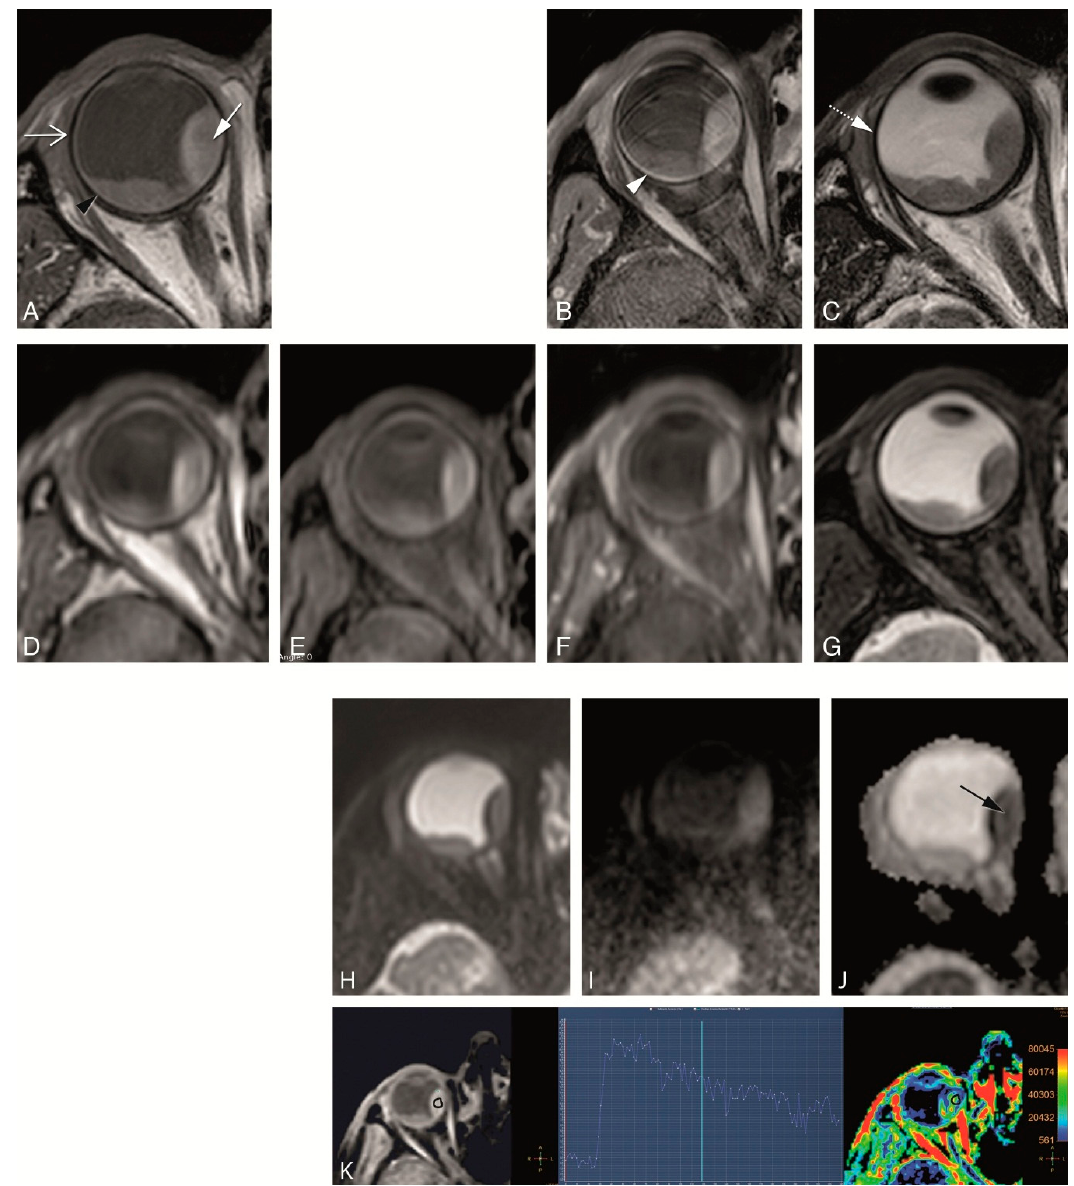
Figure 11. ( A – K ) Clinical protocol with anatomical and functional sequences in a patient with a uveal melanoma of the right eye (arrow). ( A ) MS 2 mm T1. ( B ) MS 2 mm enhanced T1 with fat signal suppression. ( C ) MS 2 mm T2. ( D ) 3D TSE 1 mm T1. ( E ) 3D TSE 1 mm T1 with fat signal suppression.